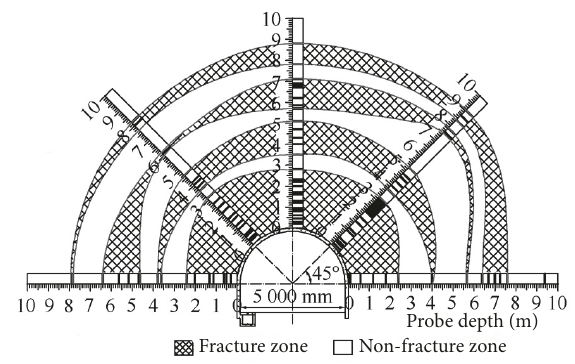
Figure 3: Zonal disintegration at Dingji mine